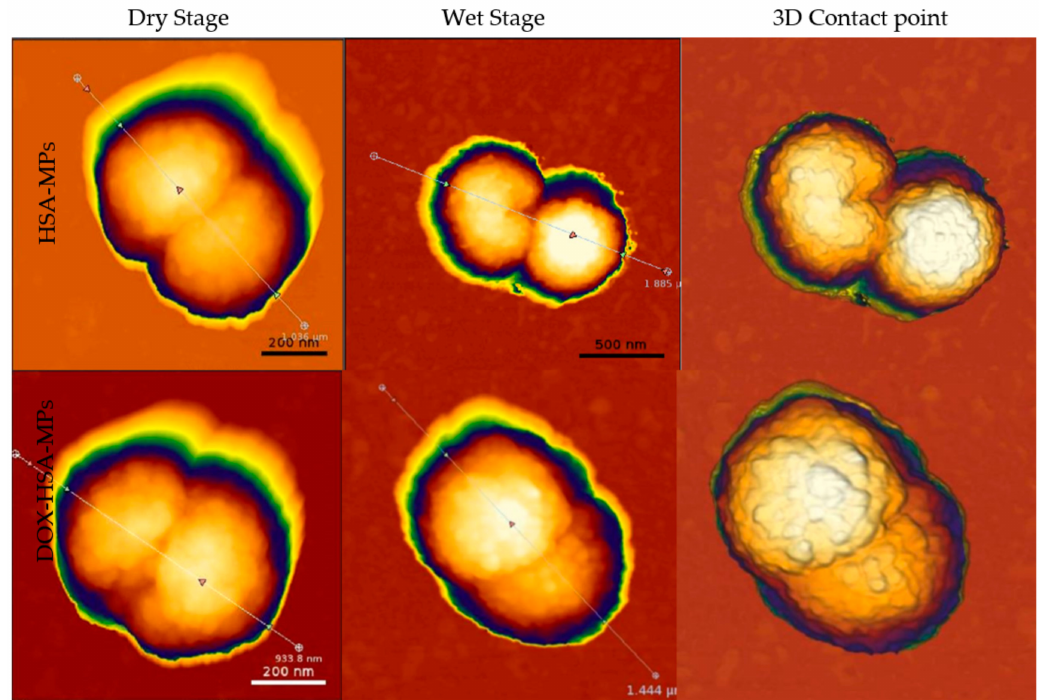
Figure 3. Atomic force microscopy images of HSA MPs and DOX-HSA-MPs particles in the dry as well as in the wet state (di ff erent scales) and as 3D contact point